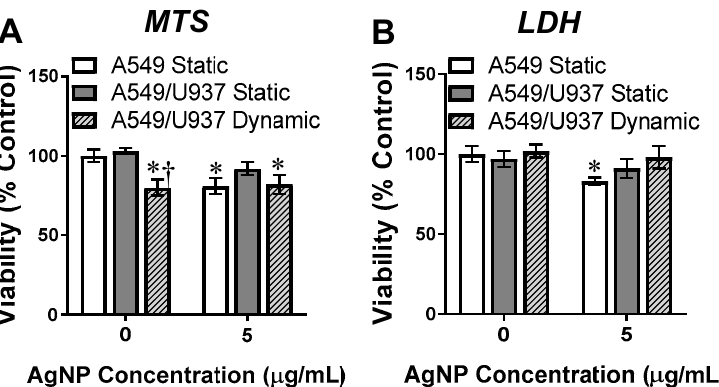
Figure 4. In vitro viability determination. The denoted cellular system was incubated for 24 h either without AgNPs or following a 5 µg/mL exposure. The in vitro models were then analyzed for cellular viability using either ( A ) MTS or ( B ) LDH assays. * and † denote statistical significance from static, untreated A549s and between A549/U937 static and dynamic at the same AgNP concentration, respectively, n = 3, p < 0.05.